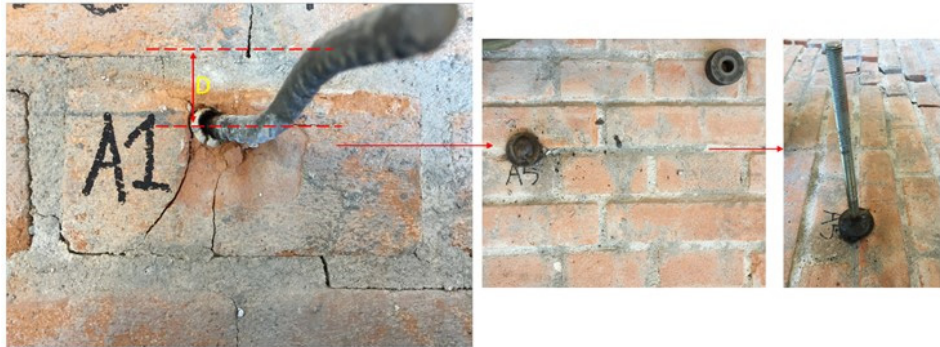
Figure 3. Examples of anchor positions.